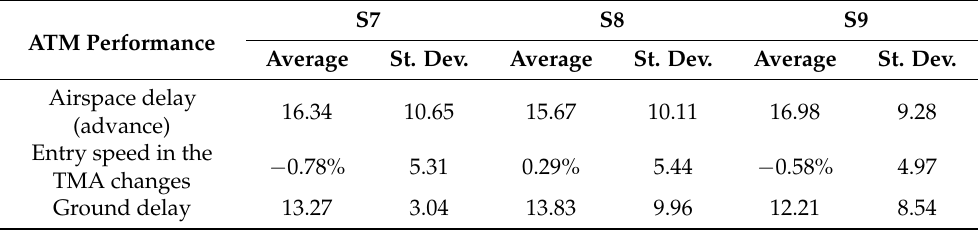
Table 12. ATM performance for Scenarios S7, S8 and S9.